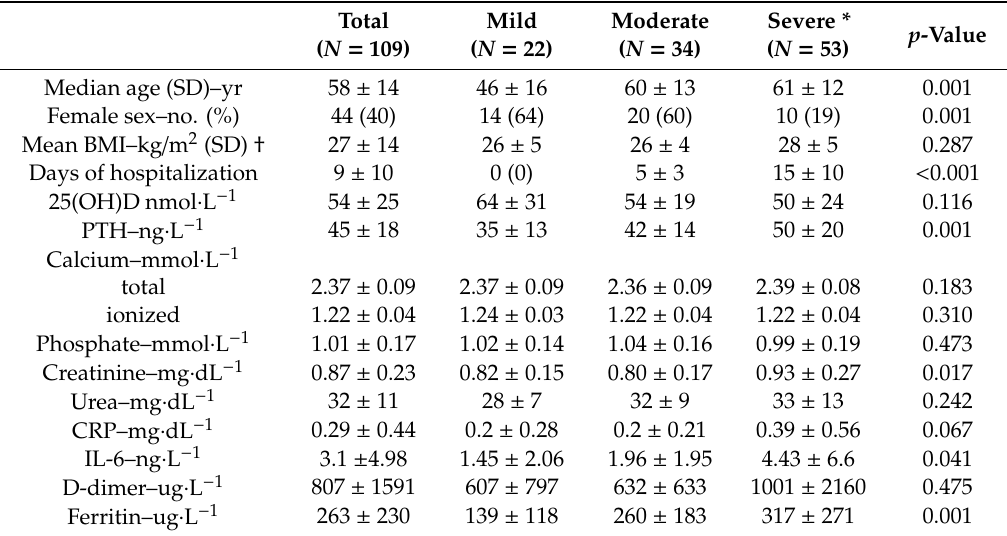
Table 2. Laboratory parameters in COVID-19 patients 8 weeks after disease onset.